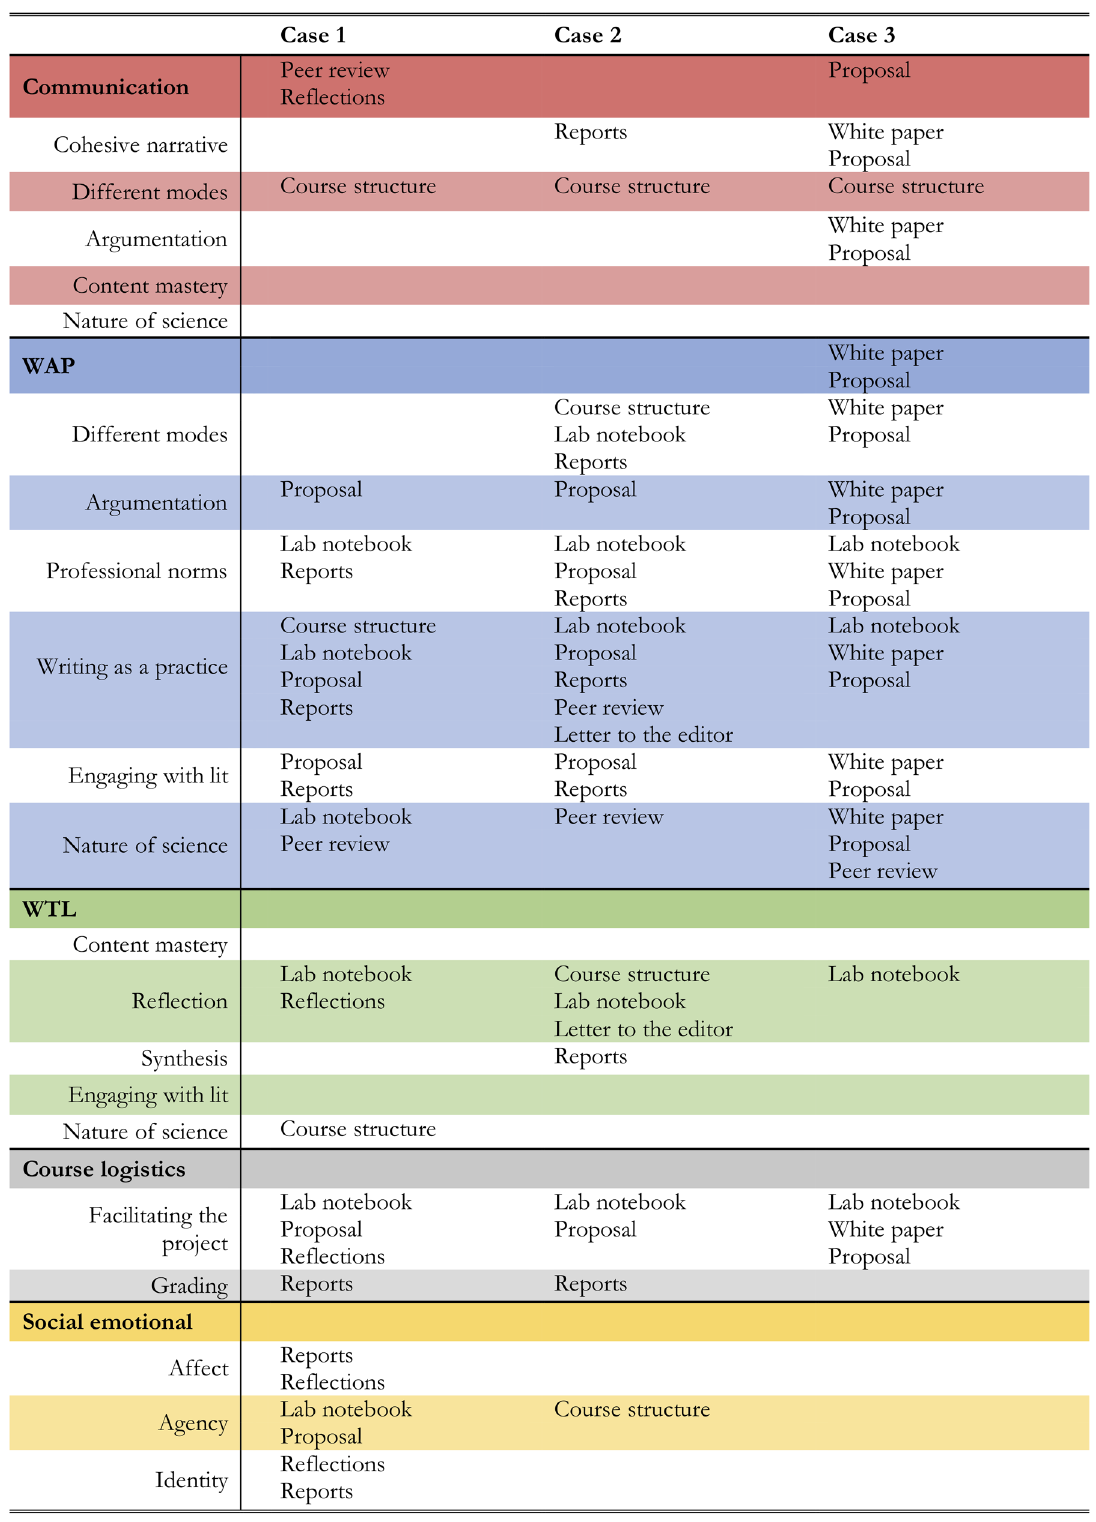
FIG. 2. Implementation of writing to address specific goals for each case. Writing used to address a category overall, but not a specific goal within that category, is indicated in the category heading row. “ Course structure ” indicates that the goal or category is addressed by the overall structure of the course and not by implementation of a specific writing